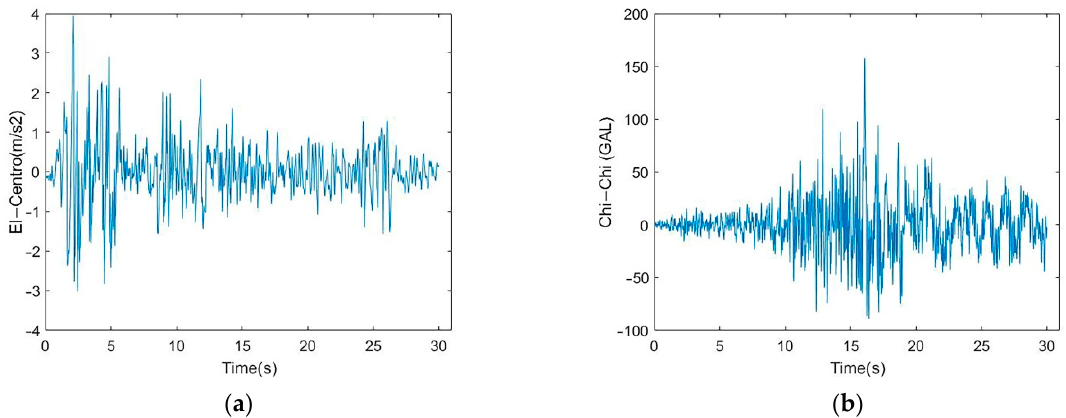
Figure 3. ( a ) El-Centro seismic acceleration records; ( b ) Chi-Chi earthquake acceleration records.